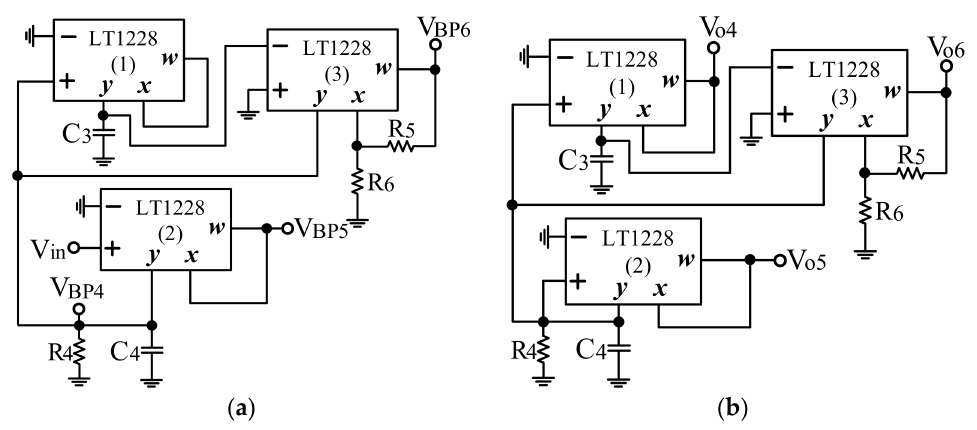
Figure 3. The second proposed isomorphic circuit of the VM NBPF and VM QSO. ( a ) VM NBPF circuit. ( b ) VM QSO